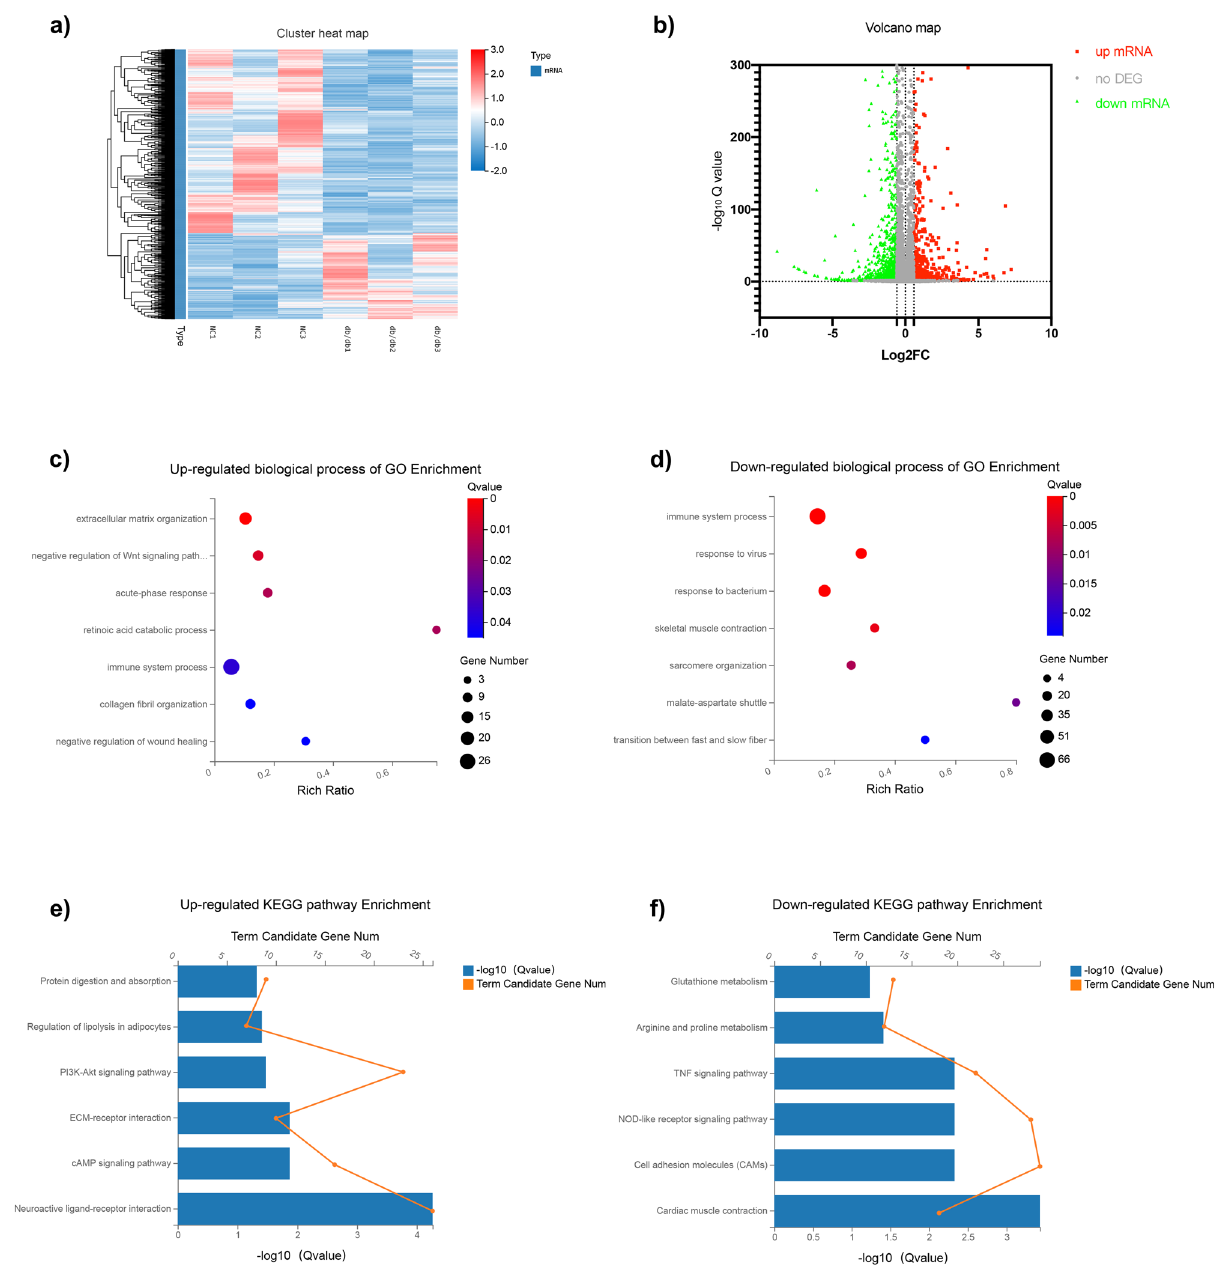
Fig. 2 RNA sequencing pro fi le and functional enrichment analysis of DEGs. a Hierarchical clustering of mRNA sequencing showed mRNA differential expression pro fi les (|log 2 FC | < 0.585, FDR < 0.05) of GAS between db/db and db/m (NC) group. Each row indicates a single gene, and each column indicates the GAS tissue of a mouse. b The scatter plot was performed for the alteration of dif-mRNAs in GAS of db/db vs. db/m ( n = 3). Red plots represent up-regulated mRNAs (log 2 FC > 0.585, FDR < 0.05) and green plots represent down-regulated genes (log 2 FC < − 0.585, FDR < 0.05). The signi fi cant GO terms (q-value< 0.05) of mRNA expression variation between two compared groups were listed ( c , d ). The top signi fi cant KEGG pathway terms (q-value < 0.05) of dif-mRNAs were listed ( e , f ). Note: NC: normal control group. GAS: gastrocnemius; dif-mRNAs: differentially expressed mRNAs; DEGs: differential expression of genes; FC: fold change; FDR: false discovery rate; GO: Gene Ontology; KEGG: Kyoto Encyclopedia of Genes and